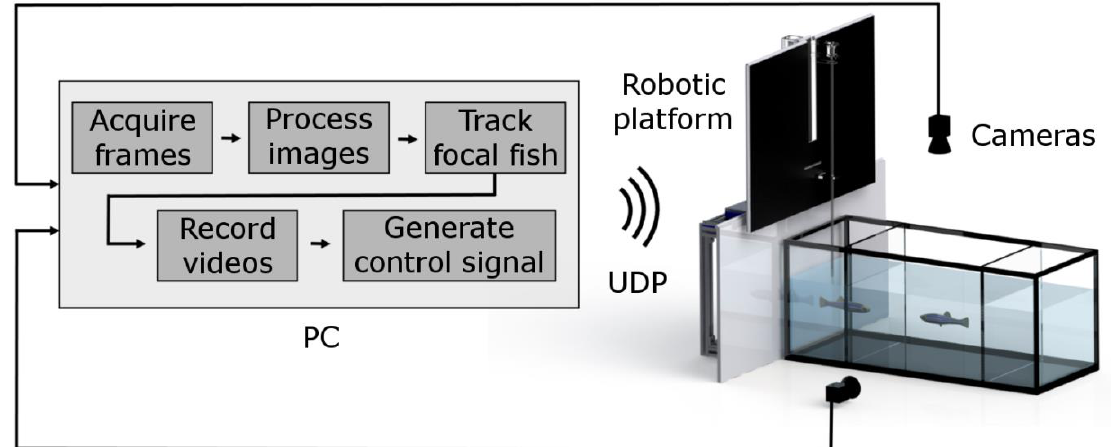
Figure 5 . Schematics of the interactive robotic platform. The base station receives an input (images) from the top and front camera. The images are processed and the fish is tracked in real-time to generate a feedback control signal that is used to maneuver the replica. For clarity, the focal fish and the robotic stimulus are magnified. [Reproduced from (Kim et al.,